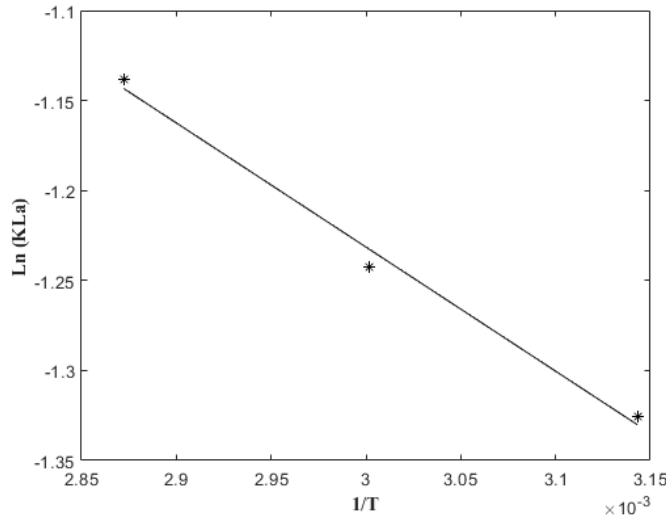
Figure 4. Activation energy calculation from plot of Ln K L a versus 1/T (*).